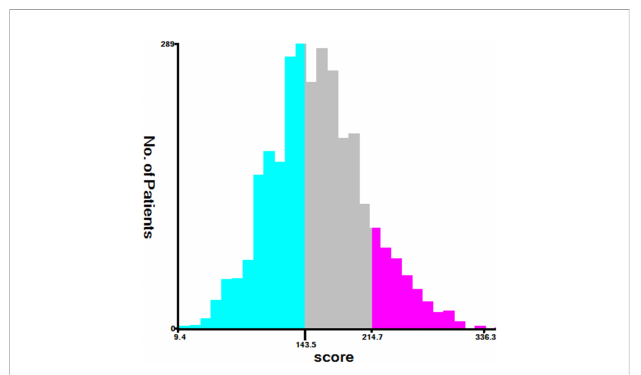
FIGURE 5 Range of risk strati fi cation based on nomogram total score.